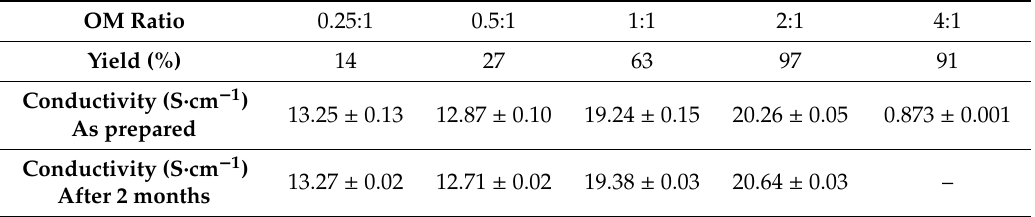
Table 1. Estimated yield of chemical polymerization and electrical conductivity values (as prepared and after 2 months) of PANI pellets for di ff erent OM